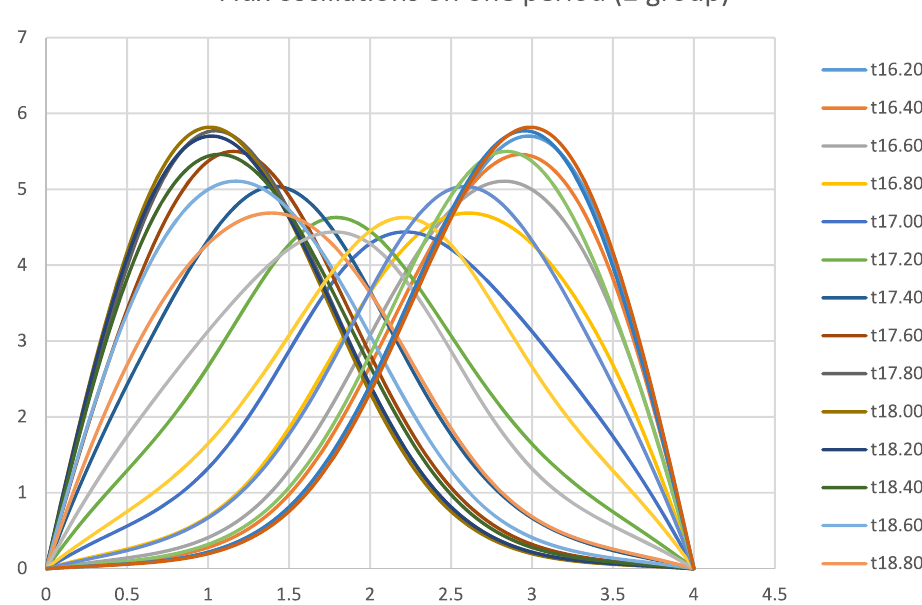
Fig. 4. The oscillation of neutron fl ux in the 2-group model with M 2